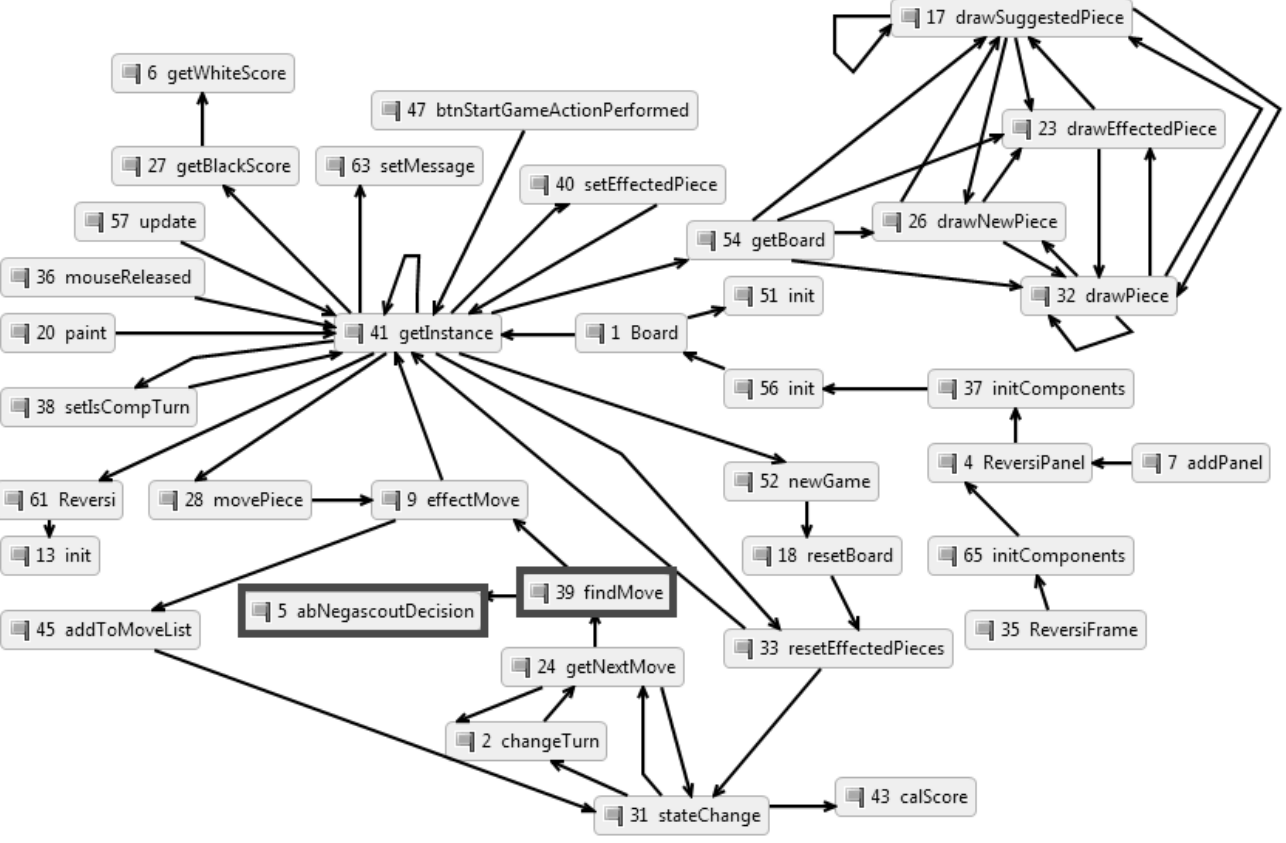
Fig. 5. Manually obtained cause-and-effect relations between functional features.